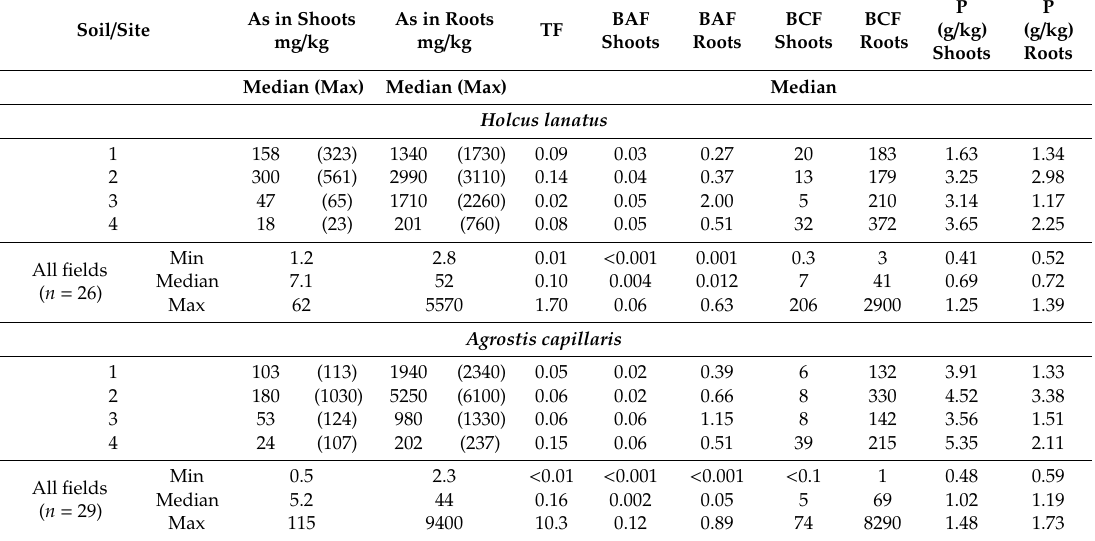
Figure 2. As concentrations in the aboveground parts of Holcus lanatus and Agrostis capillaris , and the values of translocation factors TF in the field survey and in greenhouse experiment. ( a ) Concentrations of As in grass shoots related to total As concentrations in soils; ( b ) Concentrations of As in grass shoots related to 1 M NH 4 NO 3 -extractable As in soils; ( c ) As translocation factors TF in relation to 1M NH 4 NO 3 -extractable As in soils; ( d ) As translocation factors TF in relation to As concentrations in grass roots. PV—permissible value for dry fodder (4 mg / kg). Table 3. Summary of As concentrations in plant biomass and plant-related indices (transfer, TF; bioaccumulation, BAF; bioconcentration, BCF) determined in the greenhouse experiment and in the